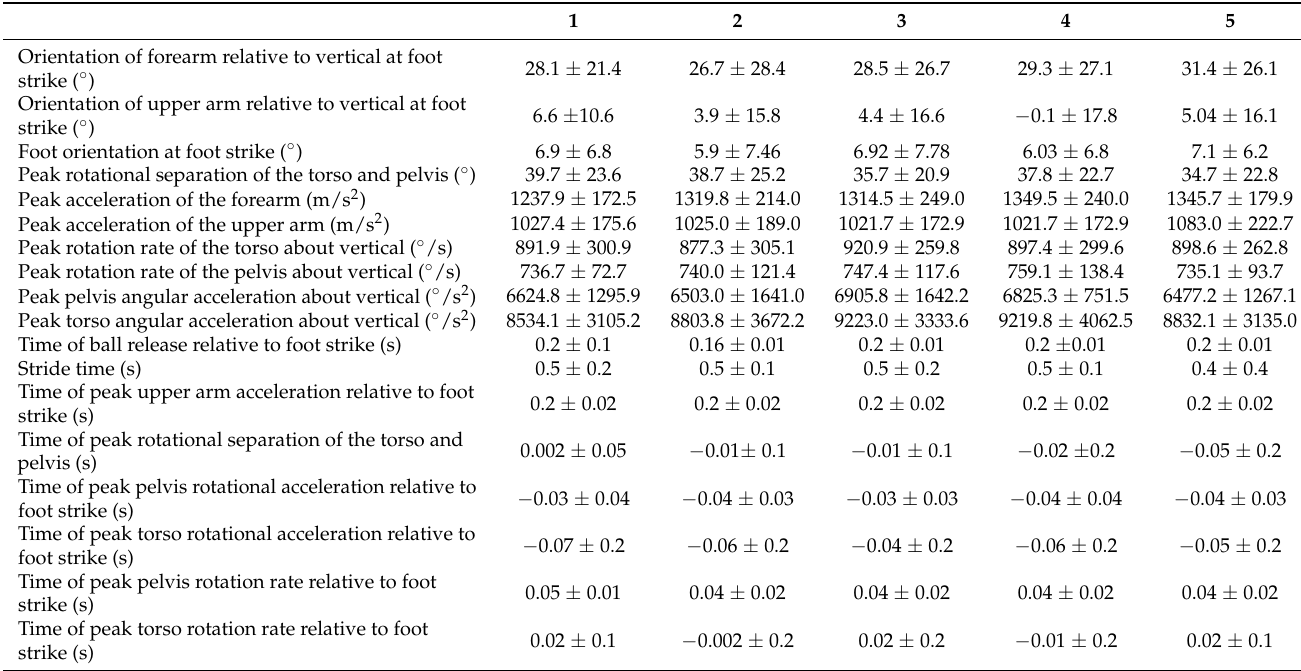
Table 3. Pitch performance and biomechanical variables (Mean ± SD) across self-reported levels of command (1–5). A score of 1 indicates the lowest self-reported command and a score of 5 indicates highest self-reported command. See Table 1 for descriptions of biomechanical variables.